Question: Identify the chart type used in this figure.
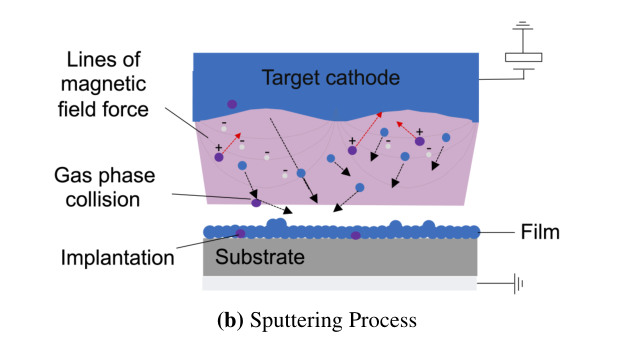
Answer: line